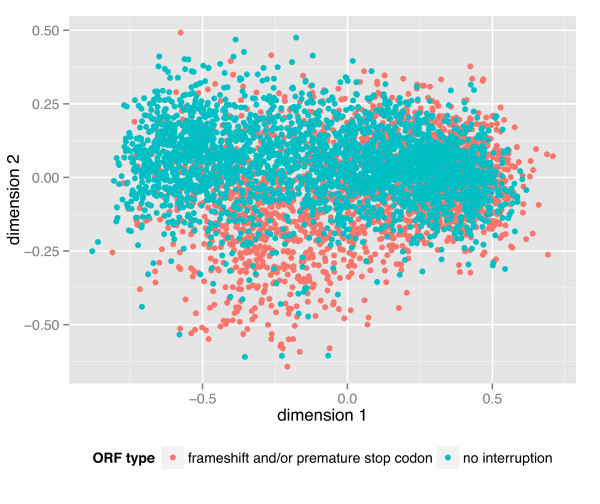
Comparison of codon usage in predicted genes and pseudogenes. A multidimension scaling scatterplot was generated from a random set of 3,000 full-length and 3,000 pseudogene-containing contigs. Pseudogenes were predicted by findorf by the presence of internal frameshifts or stop codon compared with known plant proteins.